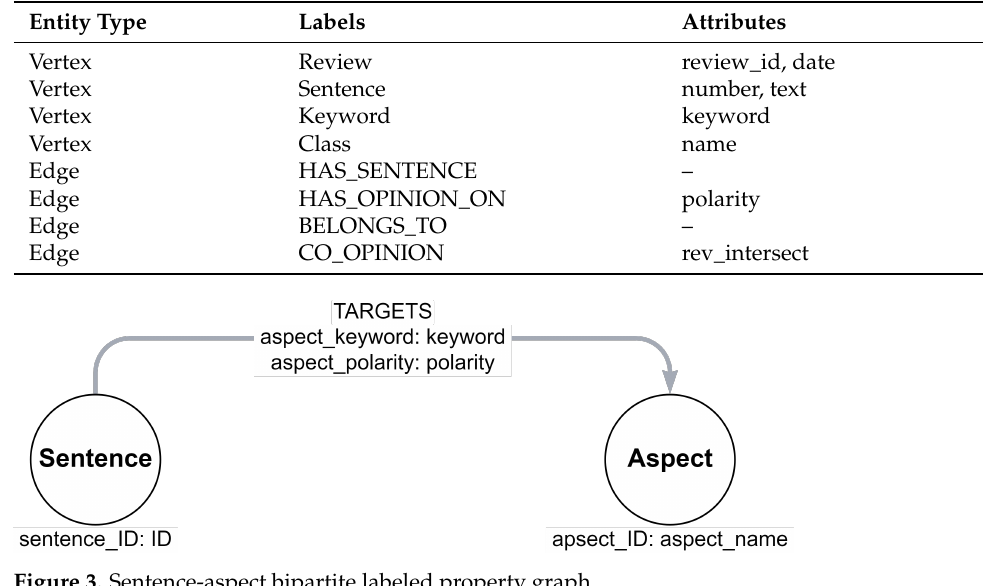
Table 1. Details of model entities.